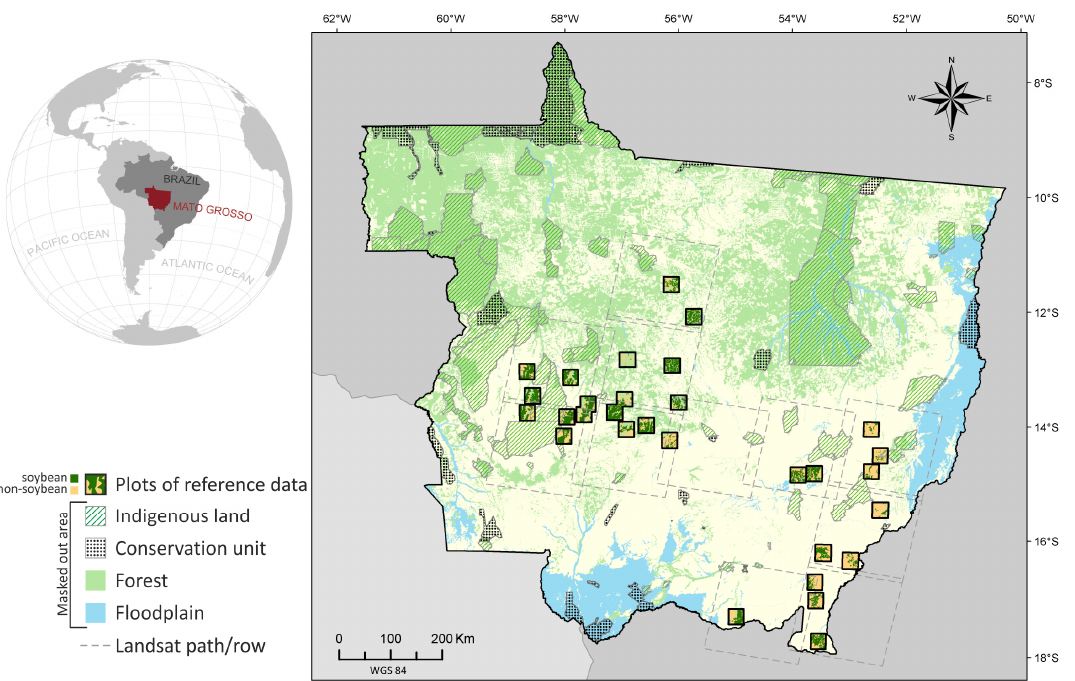
Figure 2. Study area corresponding to Mato Grosso State, Brazil. The analysis was only performed in areas that were not masked